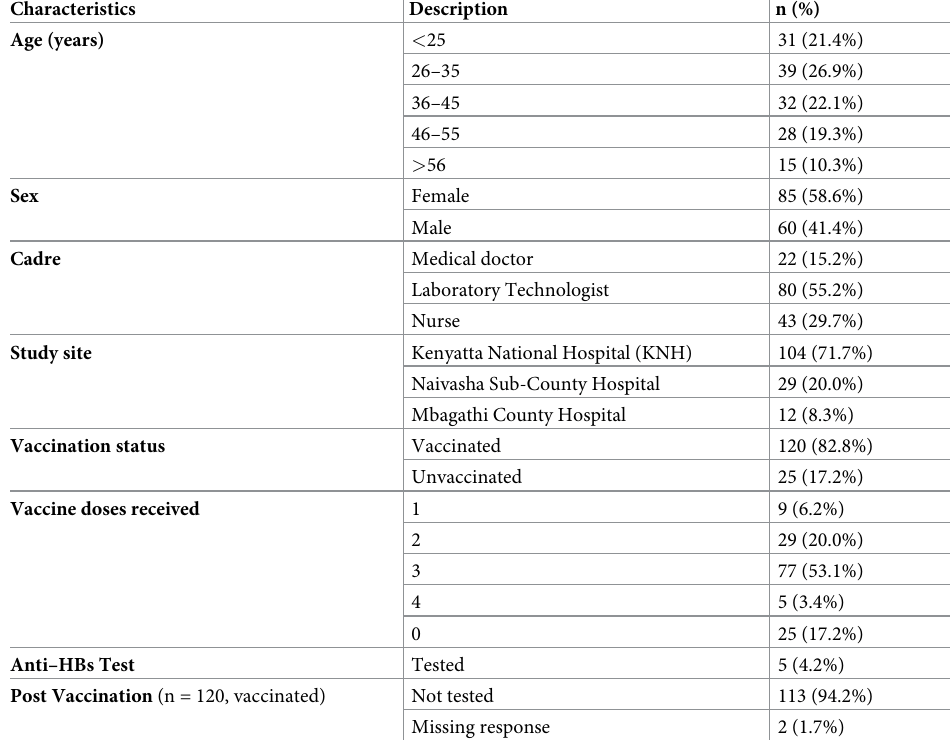
Table 1. Demographic characteristics and hepatitis B vaccination status of participating HCW at KNH, Mbagathi County and Naivasha sub-county hospitals (N = 145).